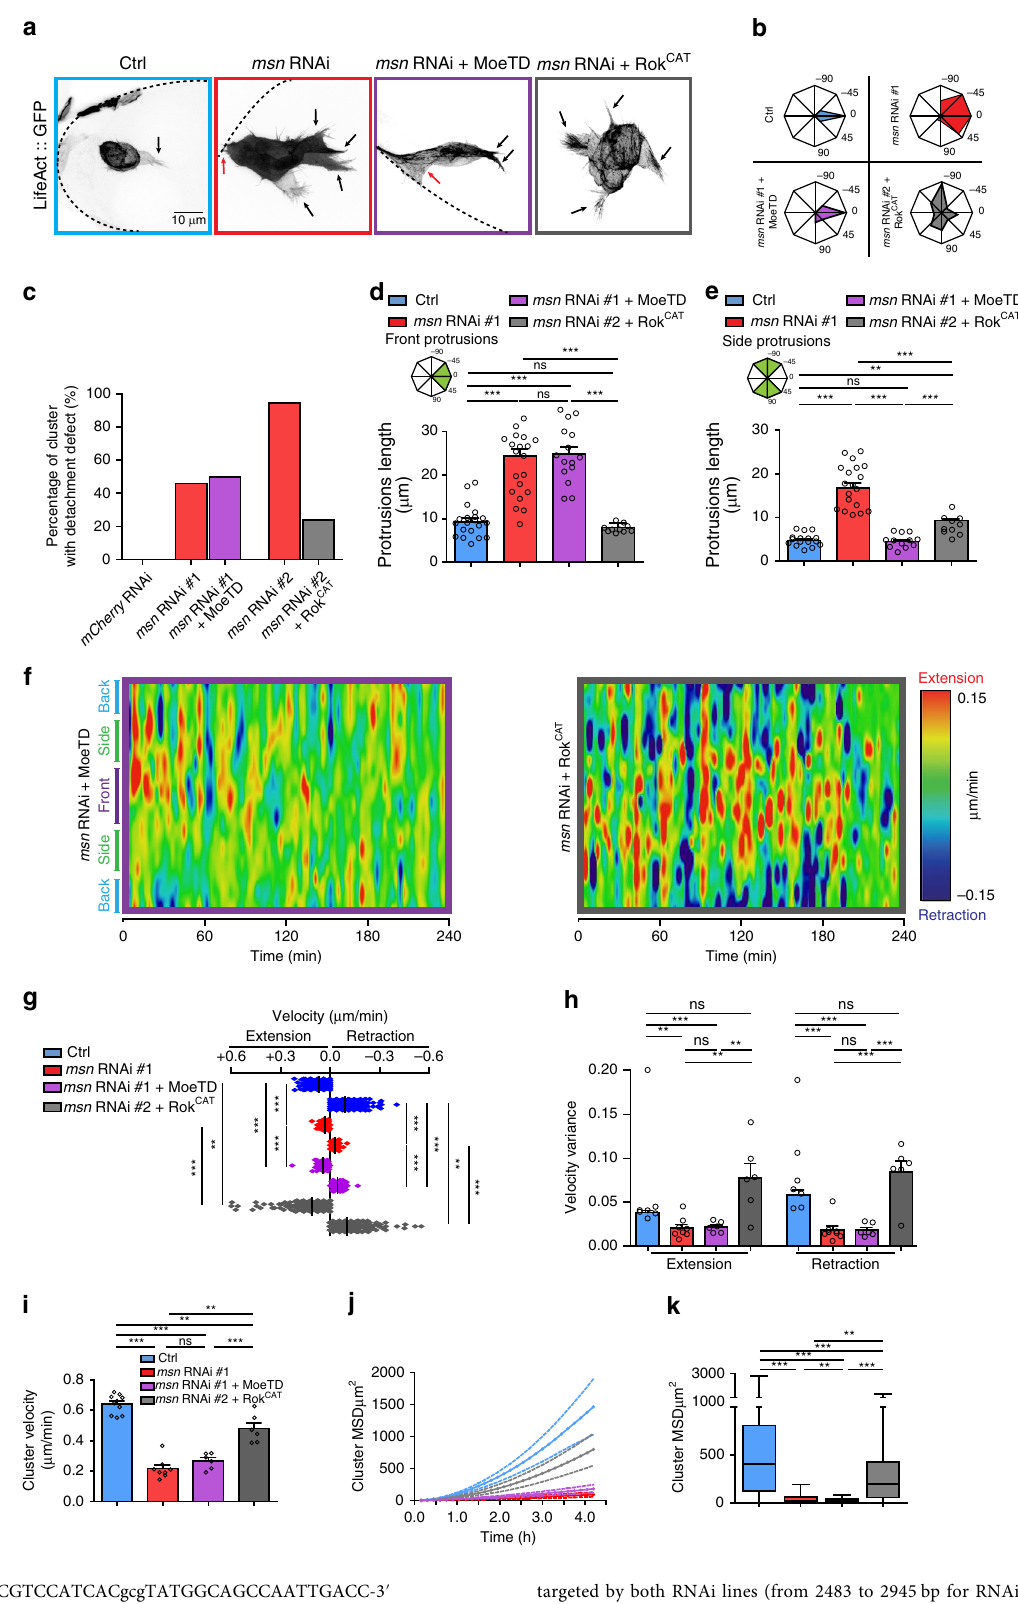
targeted by both RNAi lines (from 2483 to 2945 bp for RNAi #1 and 5 ′ -GGTGACGTCCATCACgcgTATGGCAGCCAATTGACC-3 ′ from 2279 to 2428 bp for RNAi #2). We have ordered the insensitive For the D160N mutation: sequences to gBloc, Integrated DNA Technologies (IDT). Those mutated 5 ′ -GTCATCCATCGCaacATCAAGGGGCAGAATG-3 ′ regions, were used to replace the corresponding msn region using standard 5 ′ -CATTCTGCCCCTTGATgttGCGATGGATGAC-3 ′ HA-msn-RNAi insensitive : We have generated the HA-msn-RNAi cloning methods. UAS-HA-msn-RNAi insensitive : We have sublconed HA-msn (wilt type and insensitive (wild type and kinase dead mutants) from the pA-HA-msn plasmid. kinase dead mutants) from pA-HA-msn plasmid into the pUAS-AttB-Mek The RNAi-insensitive mutants contain silent, point mutations in the regions NATURE COMMUNICATIONS| (2019) 10:3940